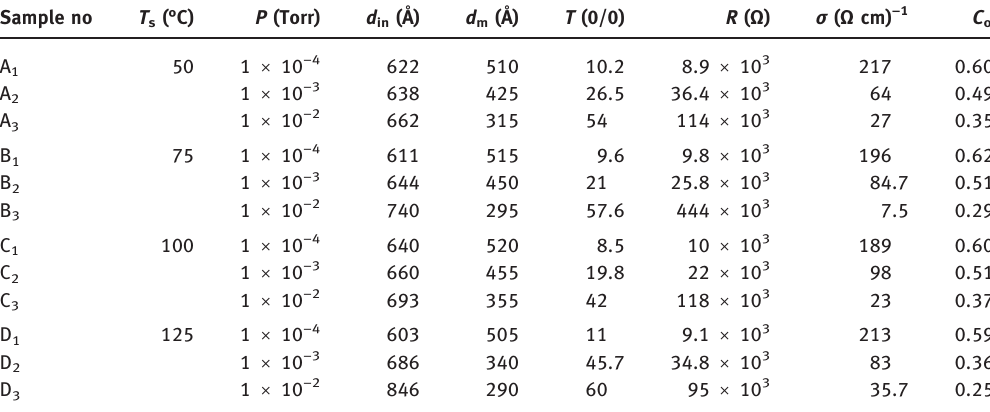
Table 1: Electrical and optical data for typical samples. Sample no